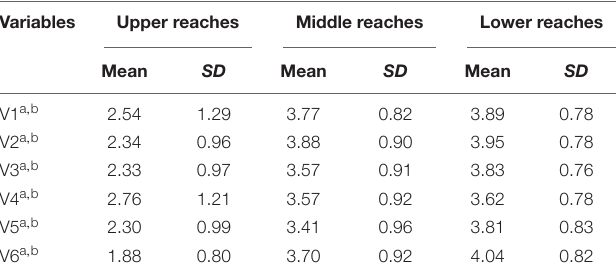
TABLE 4 | Respondents’ awareness of ecosystem services in the Xijiang River